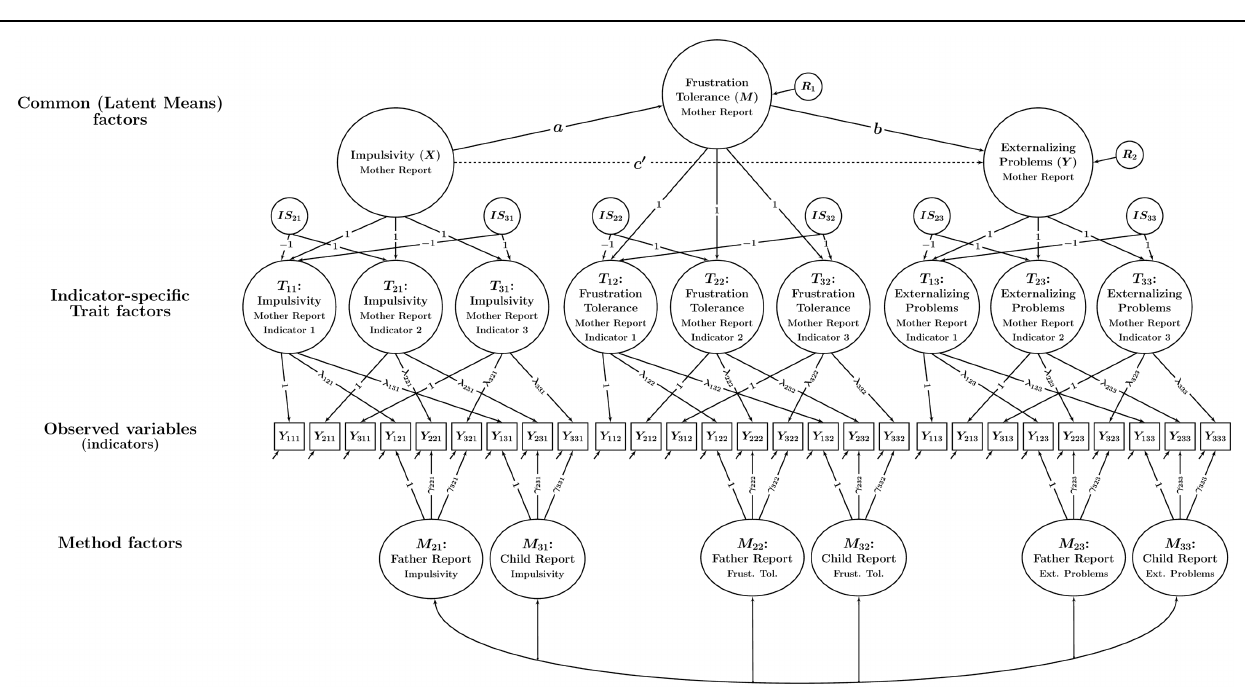
FIGURE 6 | Path diagram illustrating a CT-C( M – 1) mediation model with indicator-specific trait factors and a latent means approach used to aggregate indicator-specific trait factors. In this model, statistical mediation is examined between common trait (latent means) factors that represent averages of indicator-specific trait factors pertaining to the same trait. The latent variables IS it represent deviations of the indicator-specific trait factors from the average and reflect parcel-specific effects. All other parameters are the same as in Figure 4